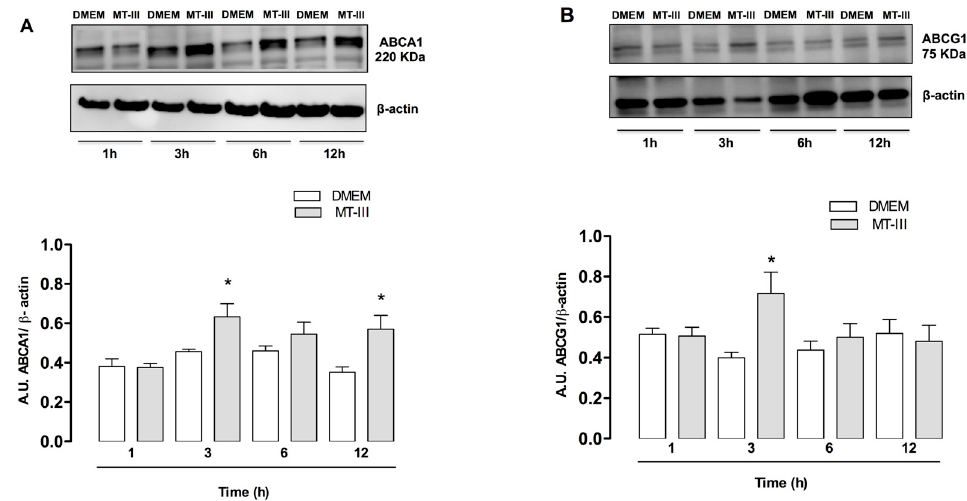
Figure 5. ABCA1 and ABCG1 are upregulated in VSMCs incubated with MT-III. VSMCs (5 × 10 4 cells/well) were incubated with MT-III (0.4 µM) or DMEM (control) for 1, 3, 6, and 12 h. ( A ) Western blotting and densitometric analysis of ABCA1 ( A ) and ABCG1 ( B ) and β -actin (loading control) in VSMC extracts. The densities were normalized with those of β -actin. The results are expressed as the mean ± SEM from three experiments ( n = 9) (ANOVA). Note: * p < 0.05 compared with control cells.